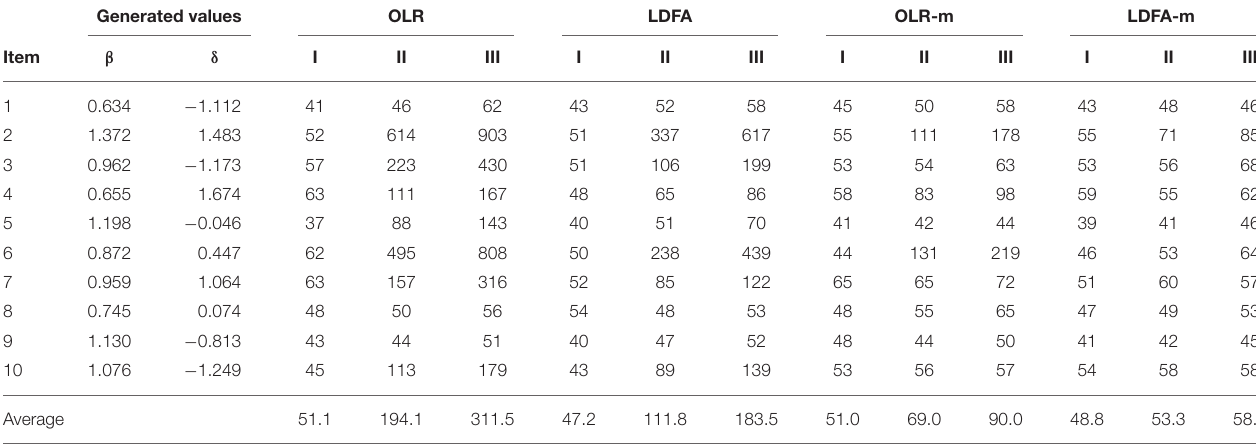
TABLE 1 | False positive rates ( ‰ ) in a 10-item test. Generated values OLR LDFA OLR-m LDFA-m